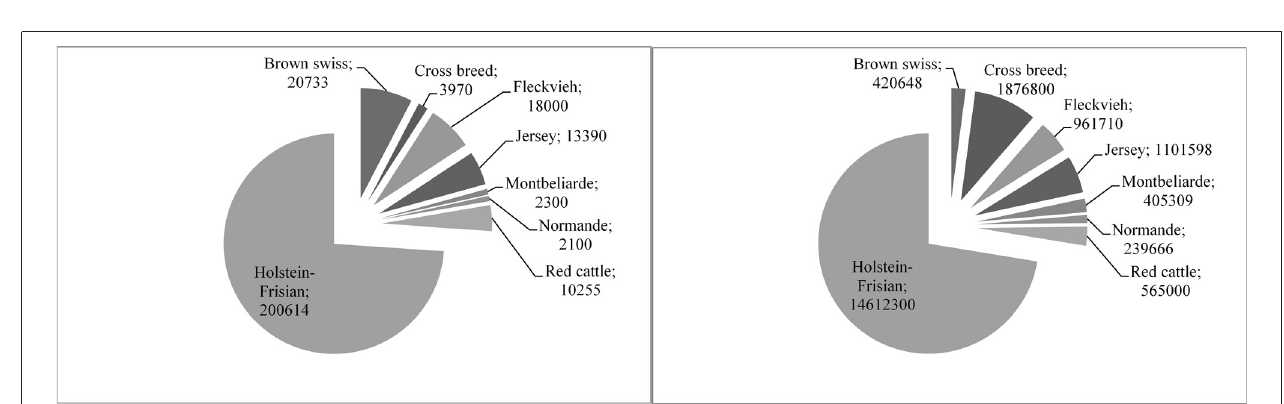
FIGURE 2 | Marker enhanced breeding using Genomic Selection in dairy cattle: Genome-wide marker panels are used to identify association or linkage with traits of interest using bulls with information on daughter lactation and genotypic data. Estimated effects of each marker are summarized into genomic estimated breeding values (GEBV), which can be used for selection. The figure assumes that GEBVs are available from an